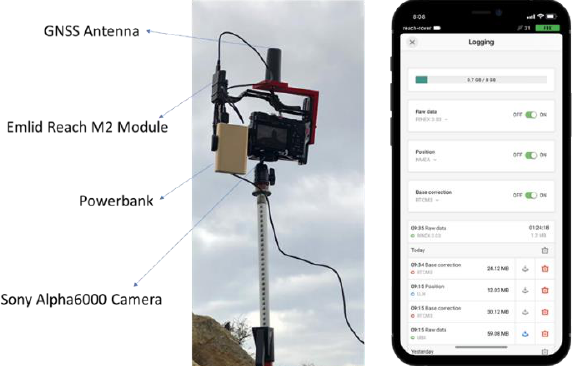
Figure 2. PPK-aided close-range photogrammetric system (left) and ReachView GUI